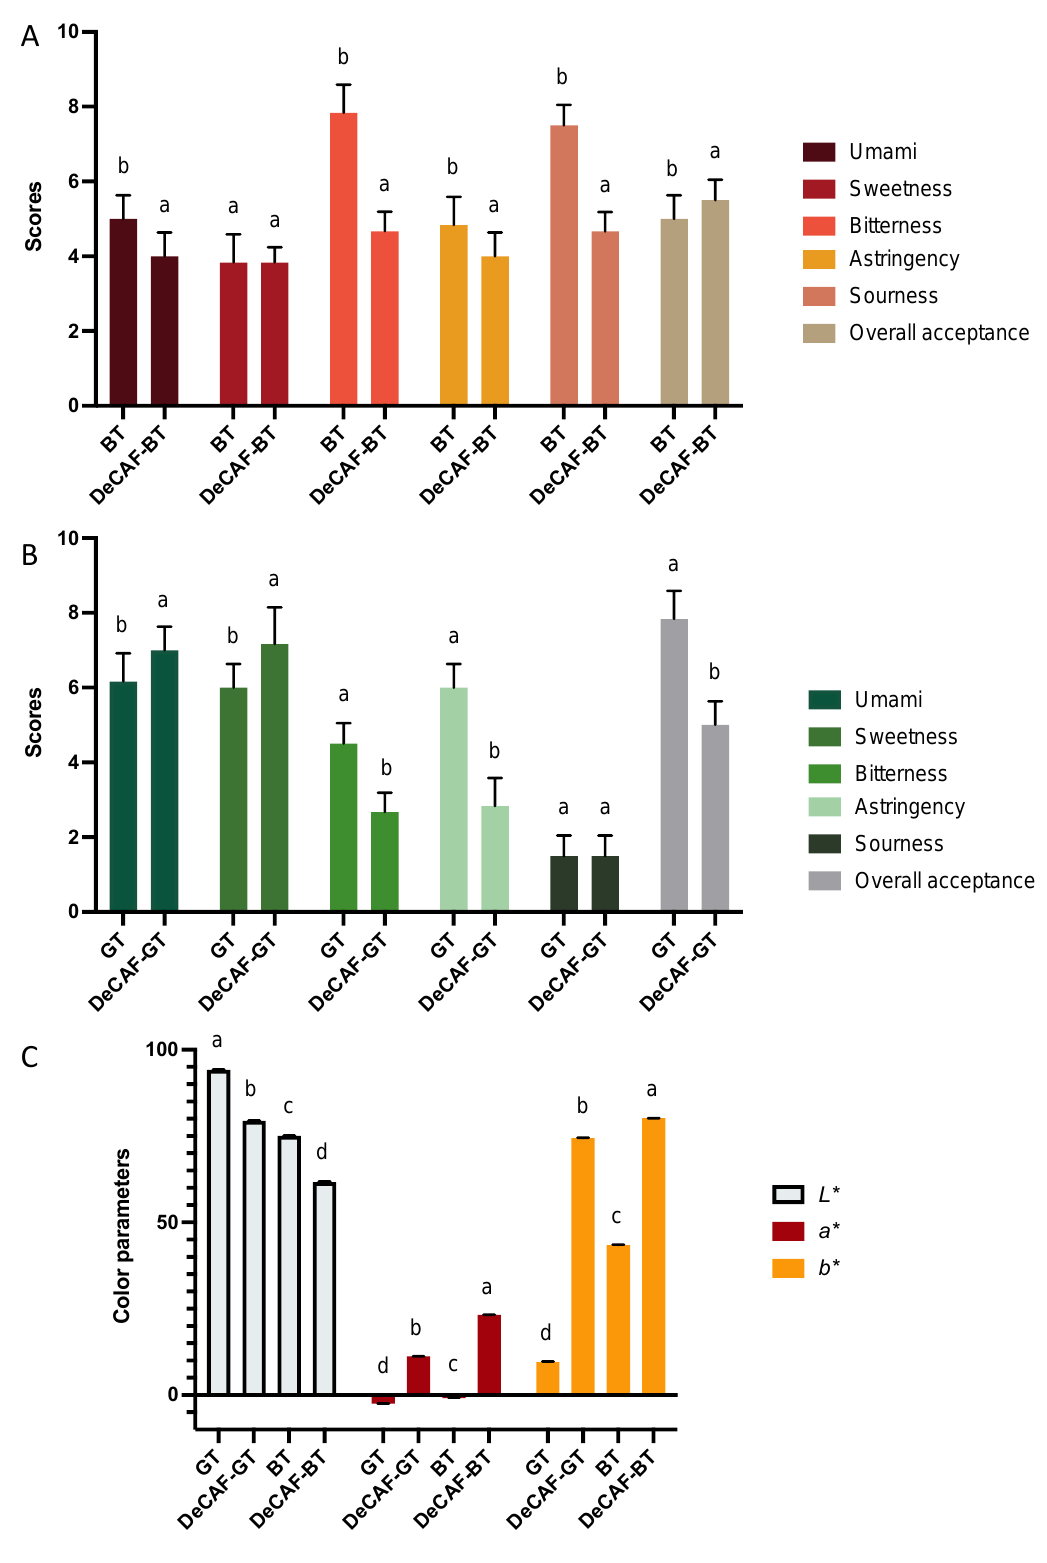
Figure 5. ( A ) The sensory qualities of black tea (BT) and decaffeinated black tea (DeCAF-BT). ( B ) The sensory attributes of green tea (GT), and decaffeinated green tea (DeCAF-GT). ( C ) The color parameters of the GT, DeCAF-GT, BT, and DeCAF-BT. Different letters for the same parameter indicate significant differences ( p < 0.05).